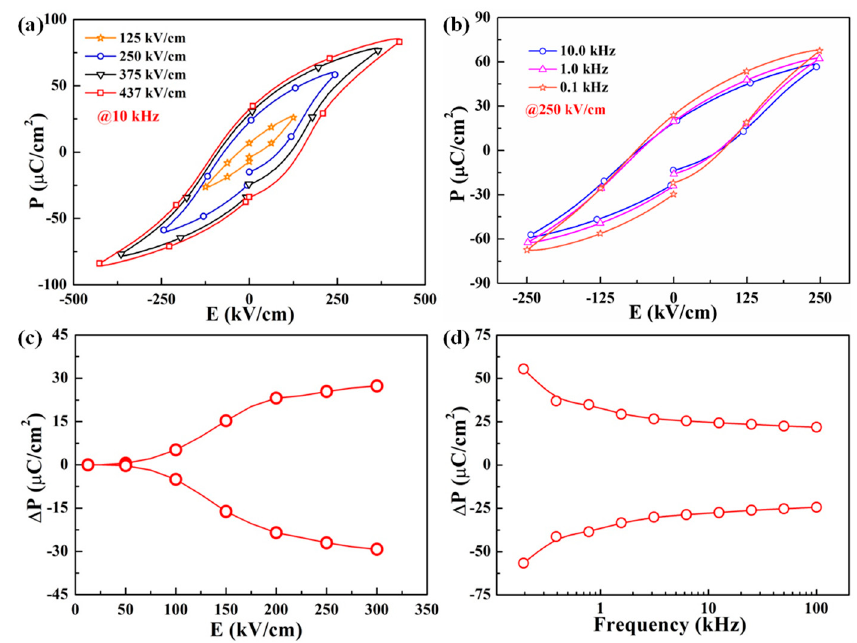
Figure 3. Electric field and frequency dependence of hysteresis loops ( a,b ) and ∆ P ( c,d ) for (110) NBT film.